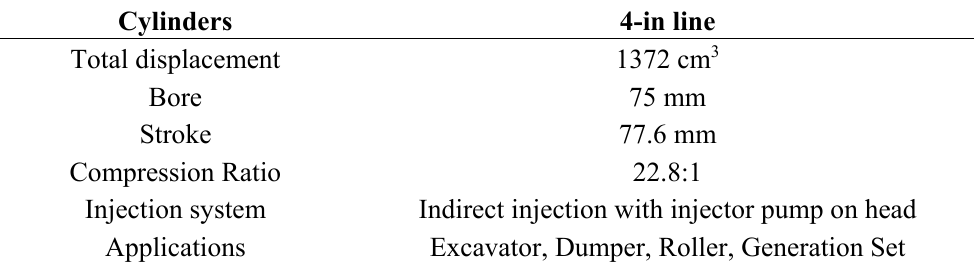
Table 2. Engine main characteristics.